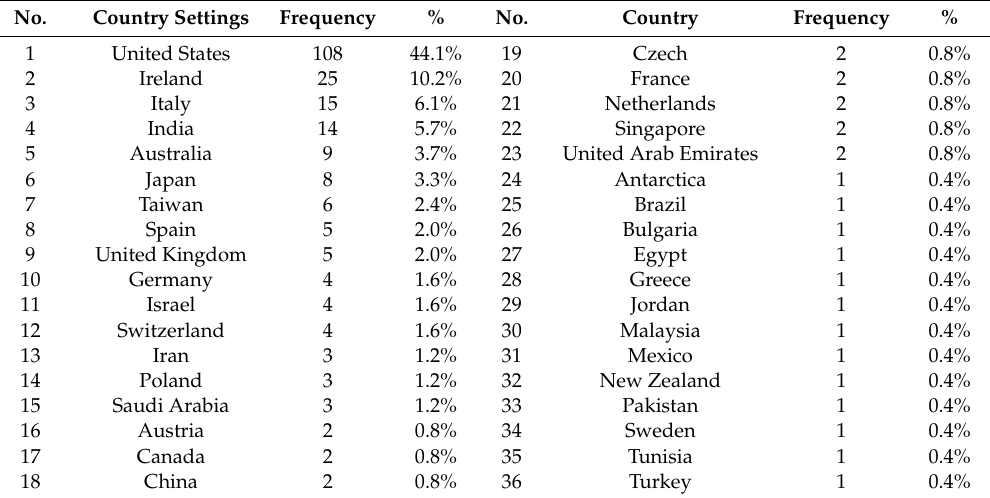
Table 3. Number of papers by countries as study